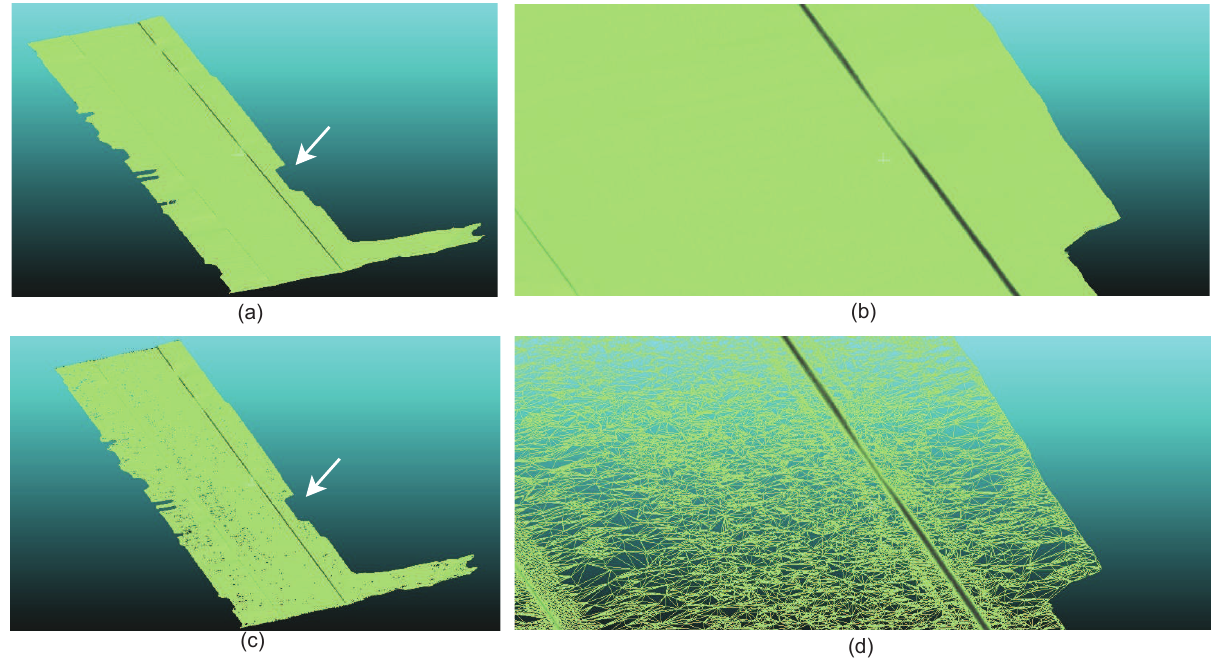
Figure 4: Decimation results obtained for the dataset Urban ♯ 1 : (a) full resolution smoothed mesh: N t = 2 . 54 Mpts; (b) zoom-in view in the area around the sidewalk border indicated by the white arrow from Figure (a); (c) wire-frame view of the decimated mesh: f D = 90% , N D : 254 kTriangles, (d) wire-frame view: zoom-in view in the area around the sidewalk border indicated by the white t arrow from Figure